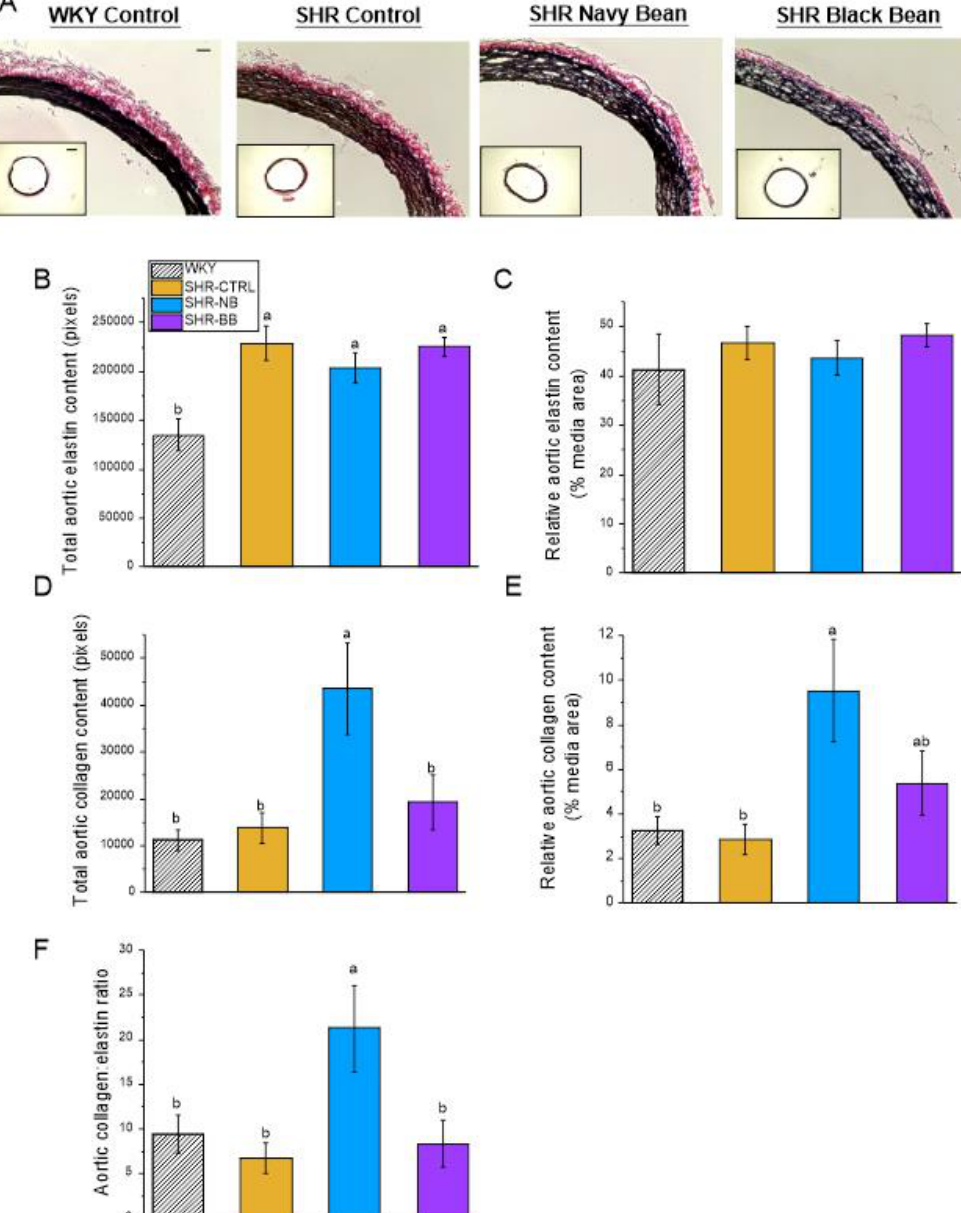
Figure 2. Phase 1: Large-artery elastin and collagen. (A) Representative cross-sections (20× objective) of aorta stained for elastin (black) and collagen (red); (B) Elastin content in aorta as total area; (C) Elastin content in aorta as % media area; (D) Collagen content in aorta as total area; (E) Collagen content in aorta as % media area; (F) Aortic collagen:elastin ratio. Aorta cross-sections were stained with an Elastin Stain Kit (Sigma); elastin and collagen contents were determined using ImageJ to quantify the area of blackness (elastin) and redness (collagen). Inset: aortic cross-sections (4× objective). Scale bar applies equally to all aorta images (bar = 50 µm). Data are expressed as mean ± SEM ( n = 6–9/group). Different letters represent significant differences ( p < 0.05). An absence of letters indicates no statistical differences. Abbreviations: BB, black bean diet; CTRL, bean-free control diet; NB, navy bean diet; SHR, spontaneously hypertensive rat; WKY, Wistar Kyoto. Wall thickness and lumen measurements (vascular geometry) were obtained via myography at a constant intraluminal pressure of 45 mmHg in mesenteric resistance arteries perfused with a Ca 2+ -